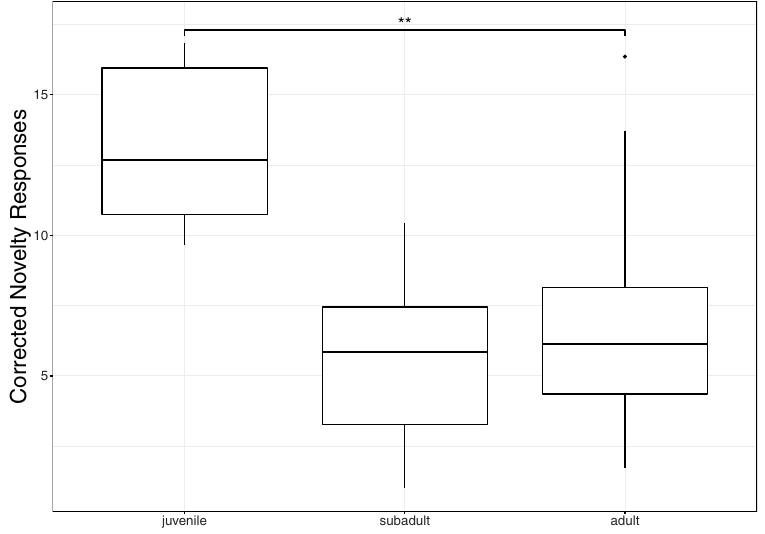
Figure 3. Age differences in corrected novelty responses; bold horizontal lines indicate median values, boxes span the first to third quartiles and whiskers represent 95% confidence intervals; horizontal lines indicate species comparisons; Significance codes: ‘ *** ’ for p < 0.001, ‘ ** ’ for p < 0.01, ‘ * ’ for p < 0.05, ‘t’ for p < 0.1 (alpha adjusted for multiple